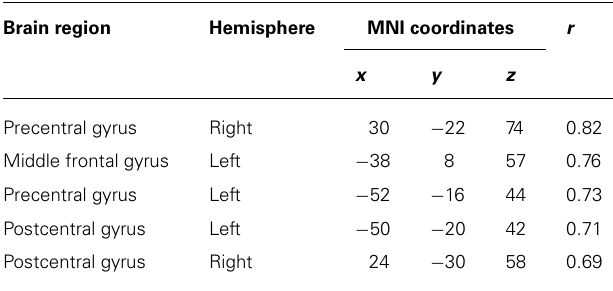
Table 4 | Coordinates of significant correlations between decoding accuracy and strength of IC during imagined